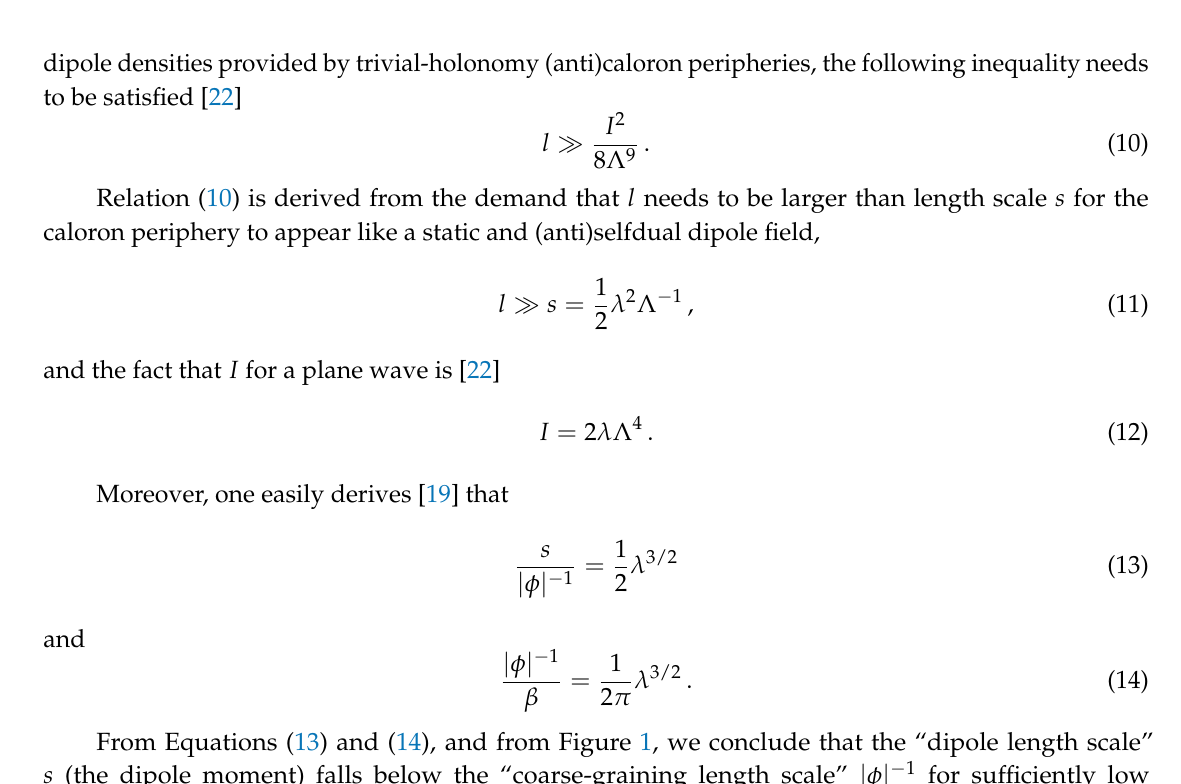
| φ | − 1 (dotted) versus small values of λ β